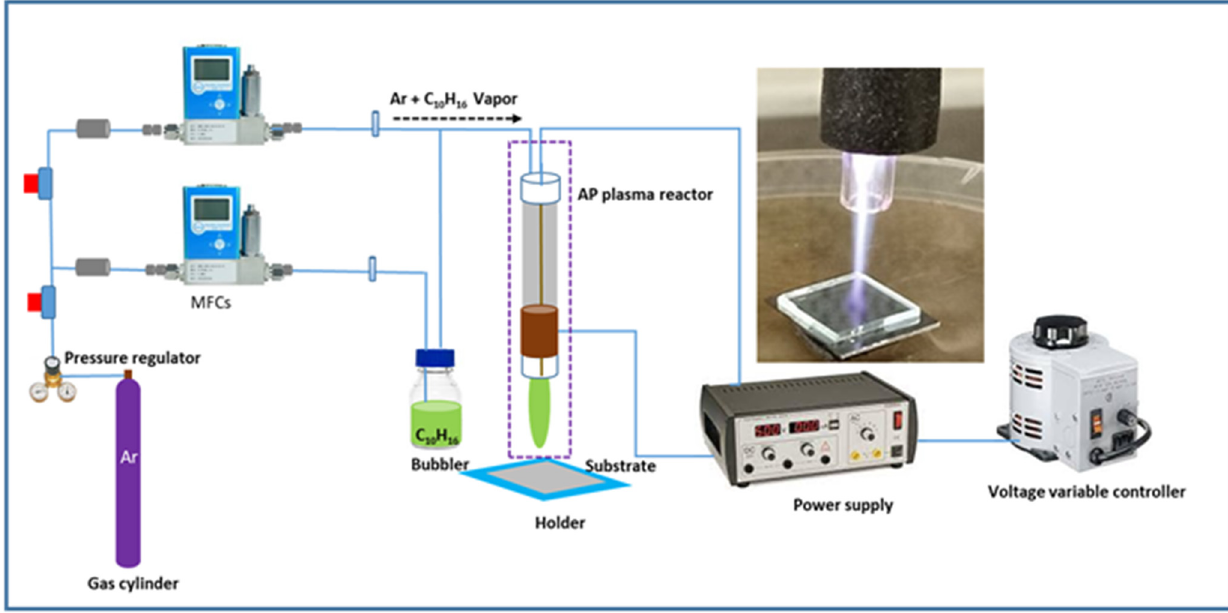
Figure 1. Schematic diagram of the APPP setup. The inset shows the photograph of plasma generated from the APPJ during the deposition process.